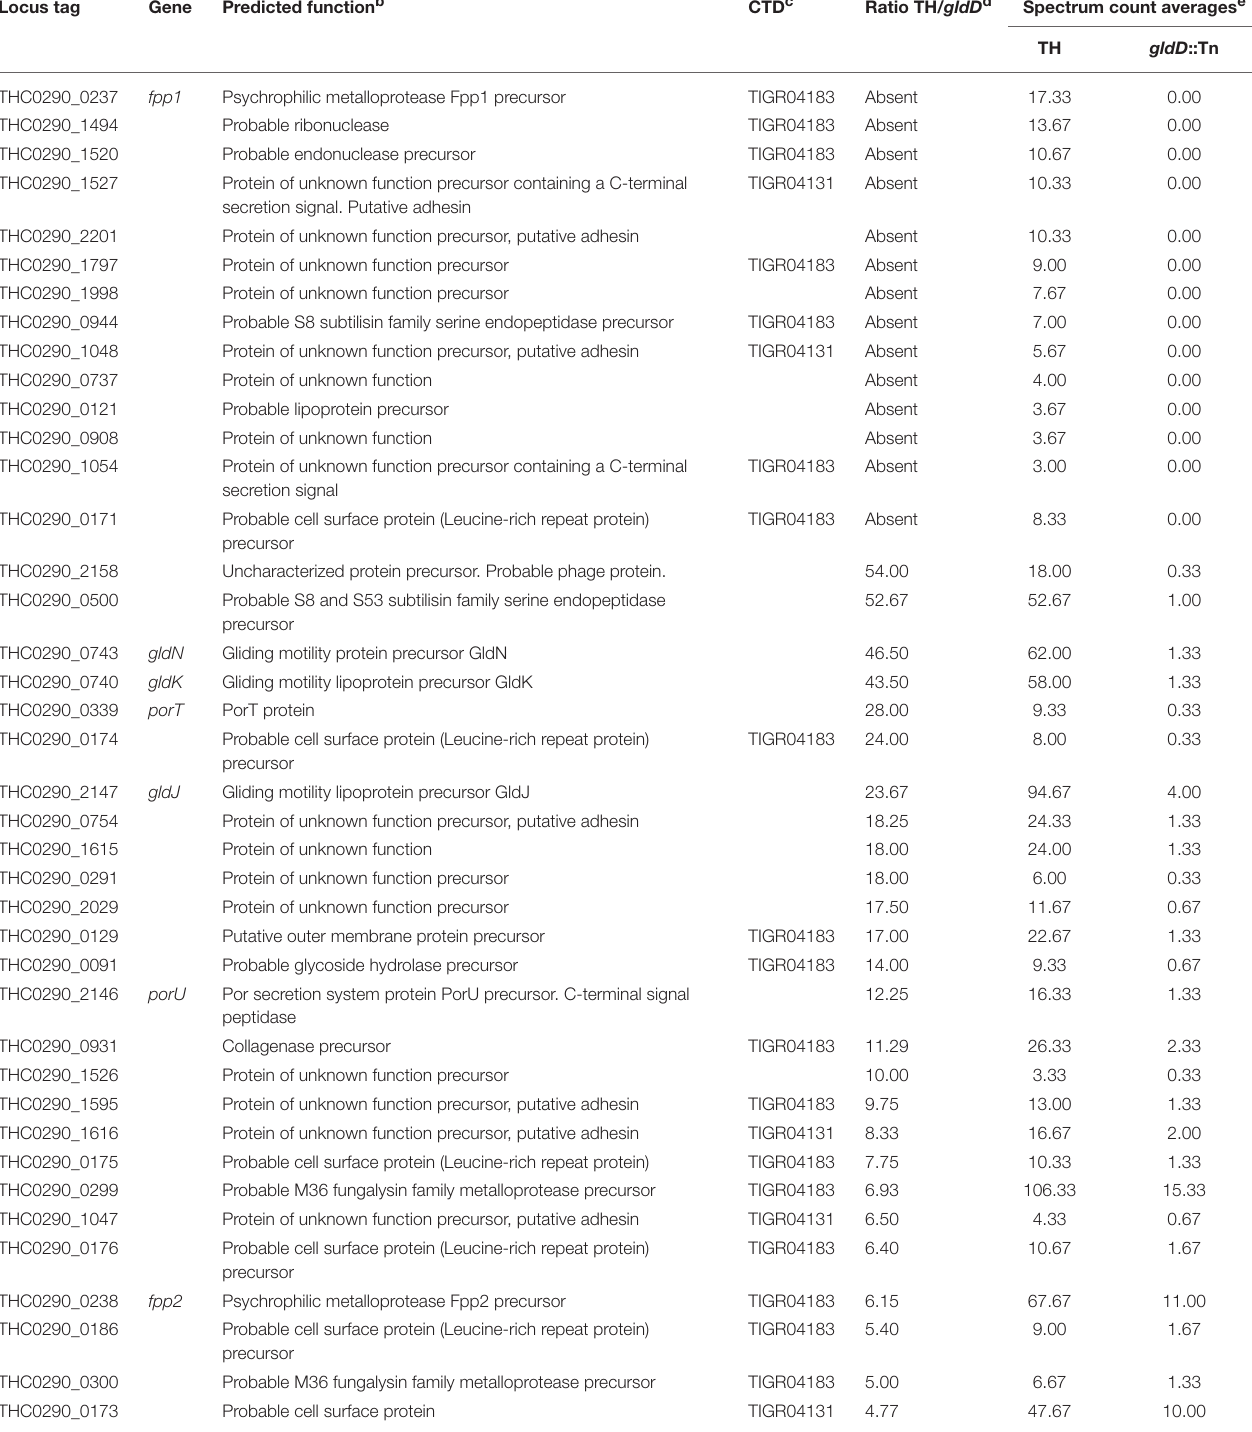
TABLE 2 | Secretome of strains THCO2-90 and gldD::Tn identified by LC-MS/MS analysis of cell-free supernatant a . Locus